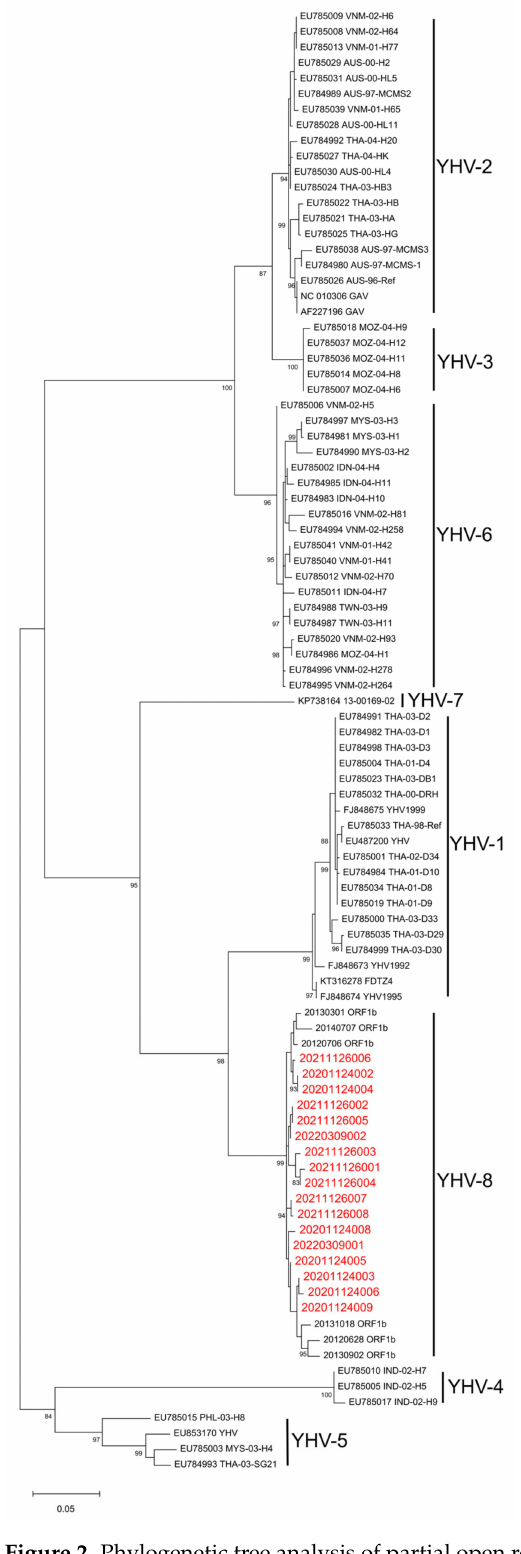
Figure 2. Phylogenetic tree analysis of partial open reading frame 1b (ORF1b) region of yellow head complex viruses (YHVs). The maximum likelihood evolutionary trees of YHVs were constructed using MEGA version 11.0.10 software. The red font represents the samples collected in this experiment. All reference sequences are downloaded from GenBank. Bootstrap values were calculated with 1000 replicates of the alignment. Percentage bootstrap values (1000 replicates) >80% are shown.